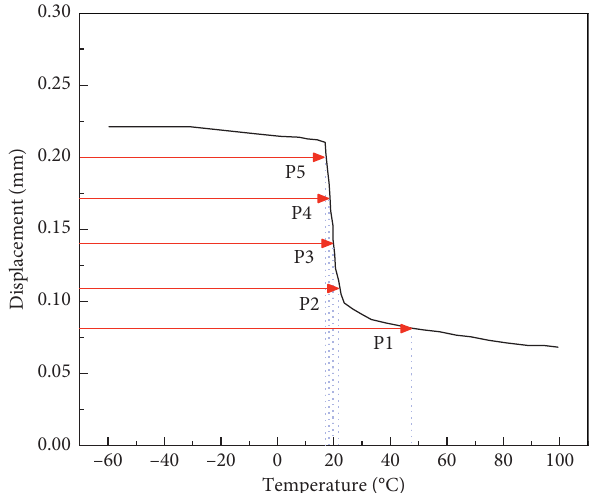
Figure 16: Variation of displacement at point A against temperature.